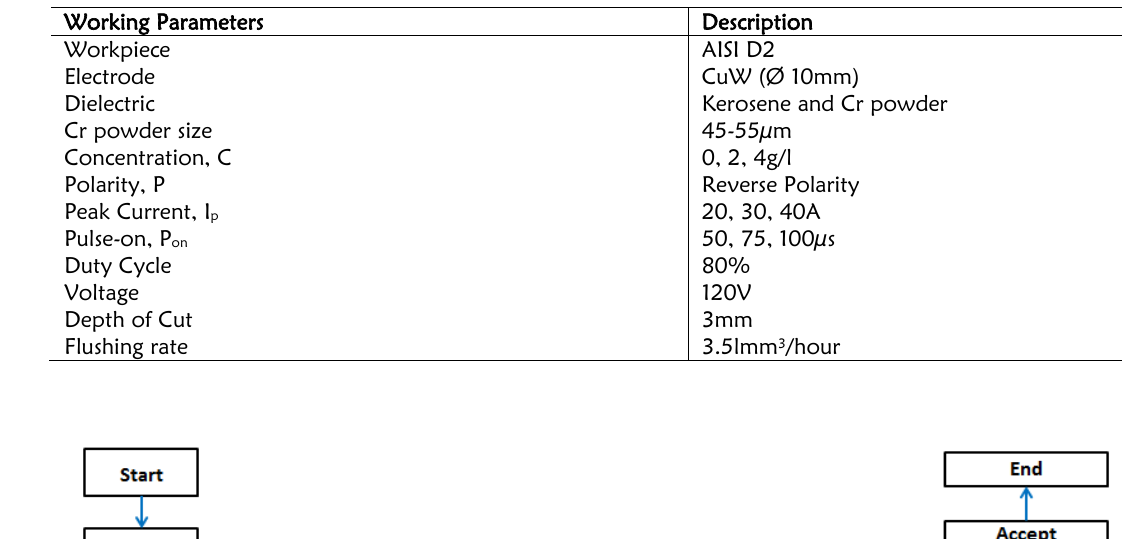
Table 2: PMEDM machining parameter.